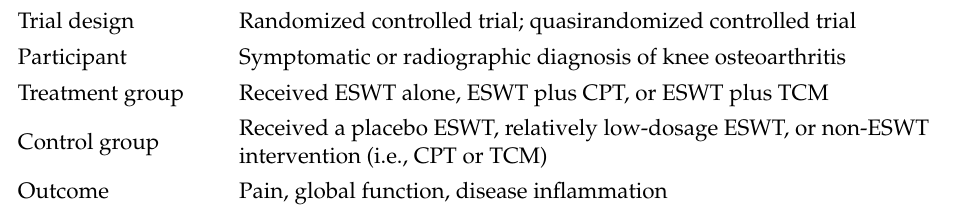
Table 1. Criteria of study